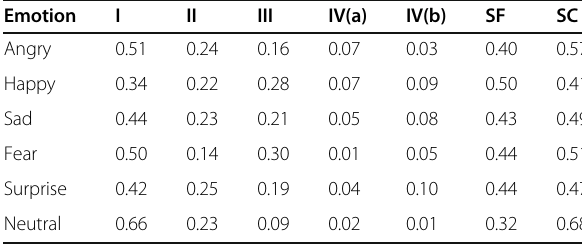
Table 4 The spatiotemporal transition of the LISA for the six emotions from weekday to